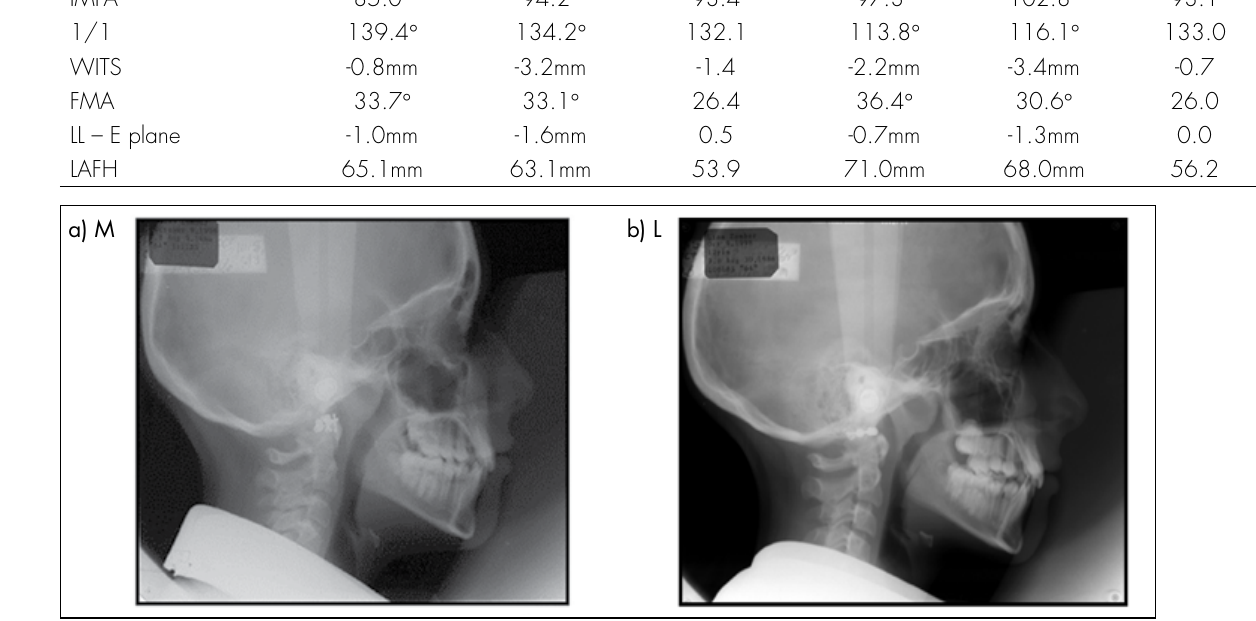
Figure 5. Pretreatment lateral cephalometric radiographs.